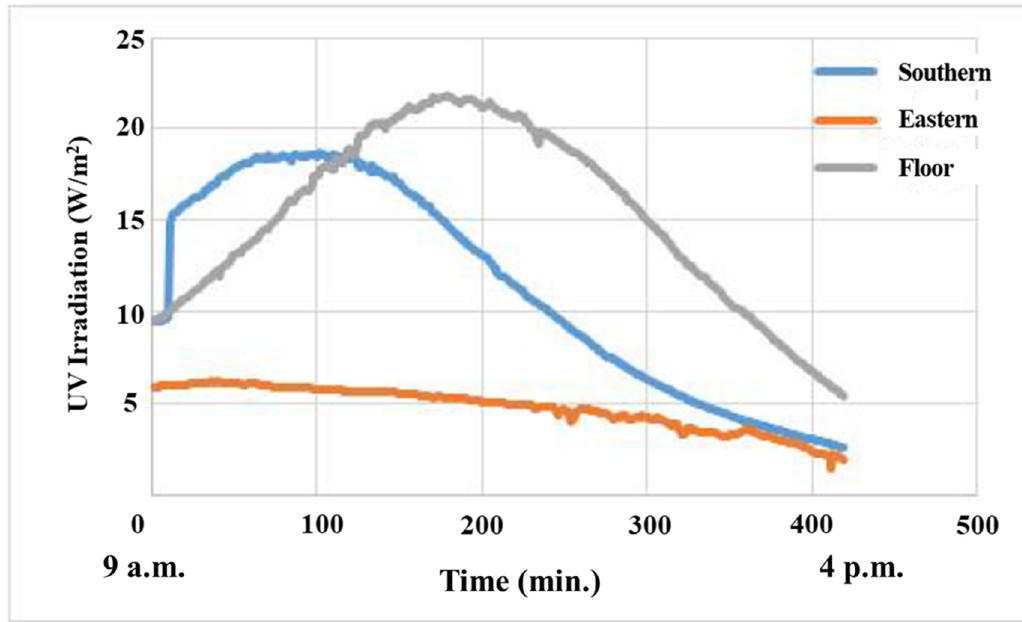
Figure 4. UV irradiation analysis results for southern, eastern and roof surfaces.